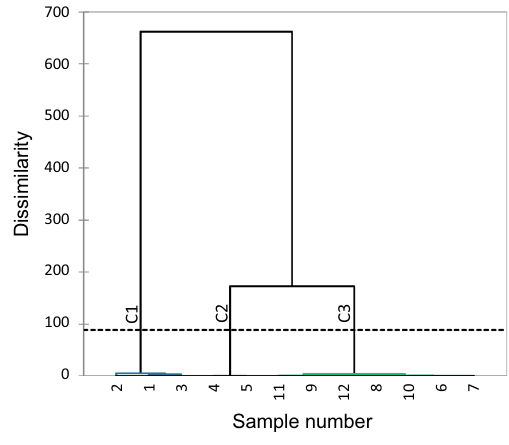
Fig. 14 Dendrogram of agglomerative hierarchical cluster